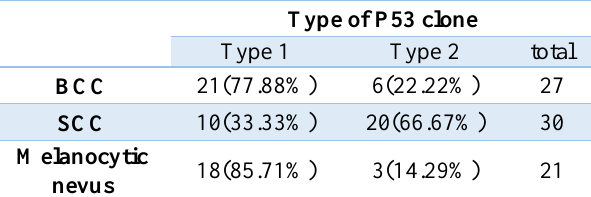
Table 2. Type of p53 clones in SCCs, BCCs